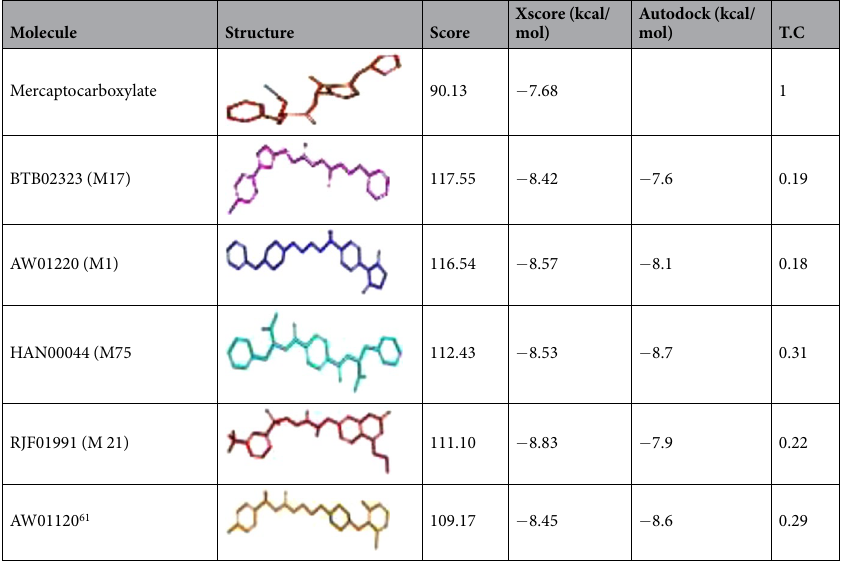
Table 1. GOLD fitness s cores and binding energies of selected five inhibitors for